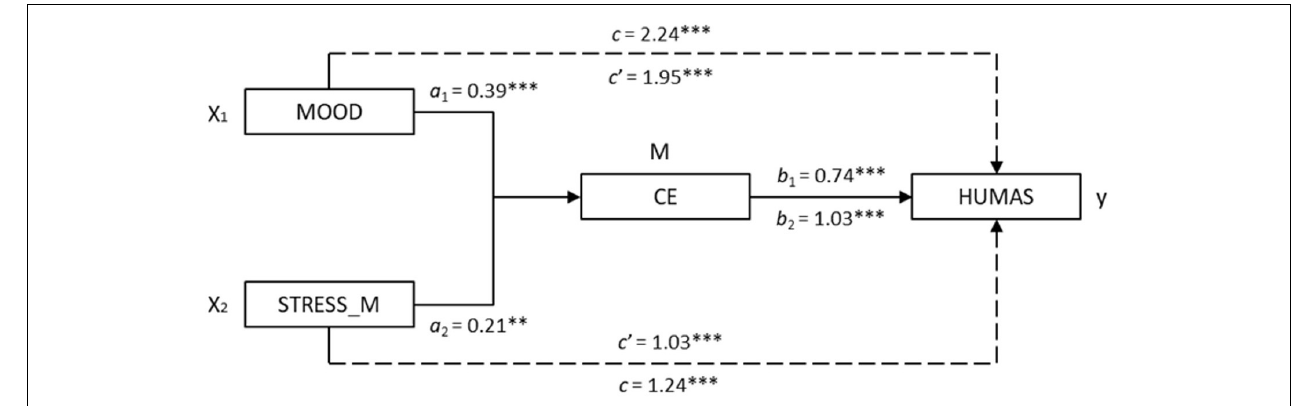
FIGURE 2 | Mediation models of Cognitive empathy on the relationship between emotional intelligence (mood and stress management) and Humanization (Note. X 1 = mood; X 2 = stress management; M = Cognitive empathy; Y = Humanization. ∗∗ p < 0.01, ∗∗∗ p <